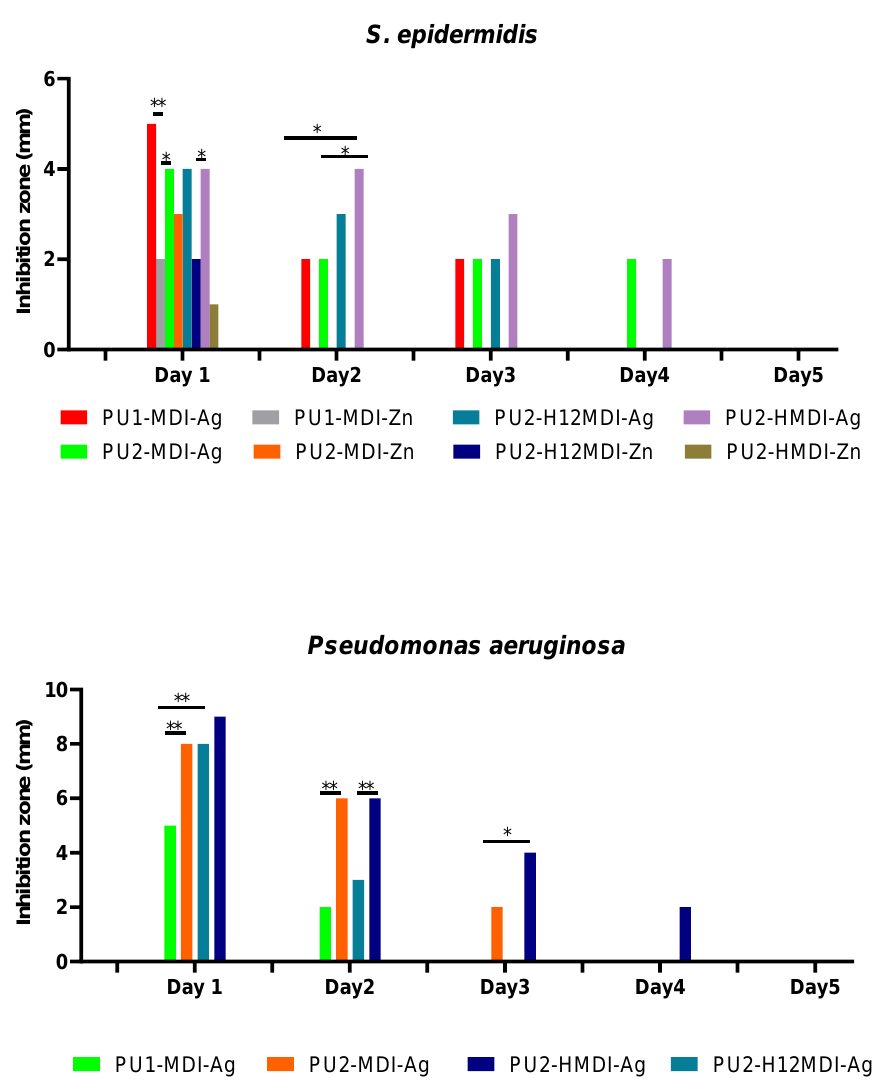
Figure 9. Inhibition halo measured around polymer disks against S. epidermidis and P. aeruginosa over time. The durability of polymer antimicrobial activity was evaluated by re-plating polymer disks every 24 h over a 5-day period. Statistical analysis showed a significant difference when * p -value < 0.05 and ** p -value < 0.01.